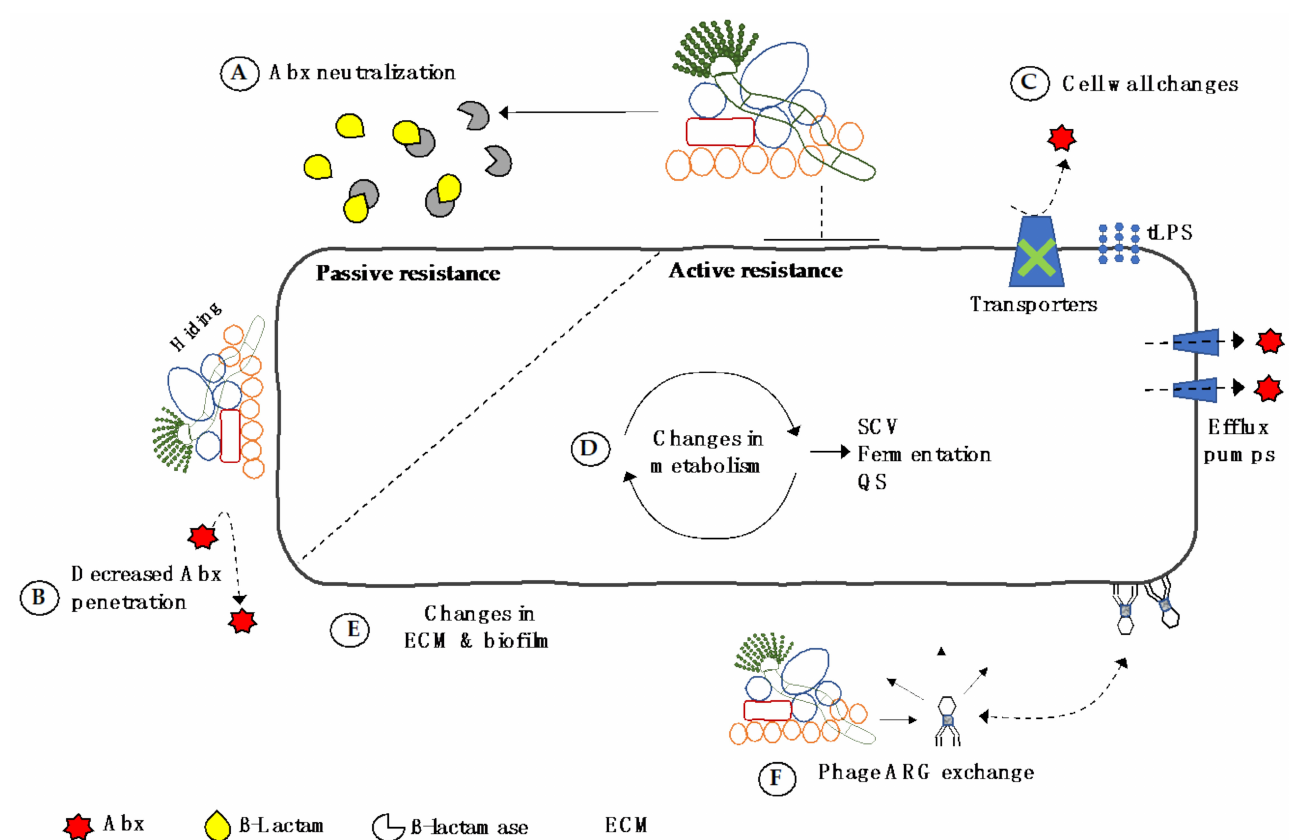
Figure 2. Passive and active mechanisms of antibiotic tolerance/resistance developed by P. aeruginosa during polymicrobial interactions. ( A ) Neutralisation of antibiotics by cleaving enzymes produced by other community members; ( B ) ‘hiding’ in multispecies biofilms reducing access of antibiotics; ( C ) changes in cell wall architecture, including truncated LPS, increased expression of efflux pumps, or reduced activity of membrane transporters; ( D ) changes in metabolism resulting in alterations to growth and quorum sensing, development of SCVs, and conversion to fermentative growth; ( E ) increased or decreased production of ECM and biofilm growth; and ( F ) transfer of mobile ARGs via bacteriophage. Abx = antibiotics, ECM = extracellular matrix, SCV = small colony variant, QS = quorum sensing, tLPS = truncated lipopolysaccharide, ARGs = antibiotic resistant